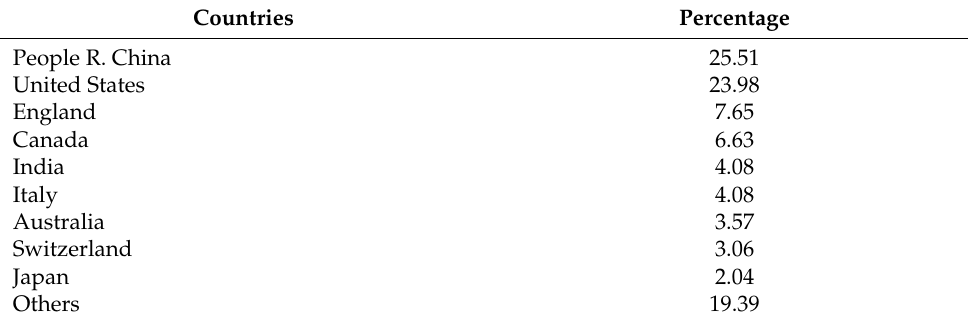
Figure 2. Number of publications per year (1993–2020). Table 1. Countries of the authors of the publications.